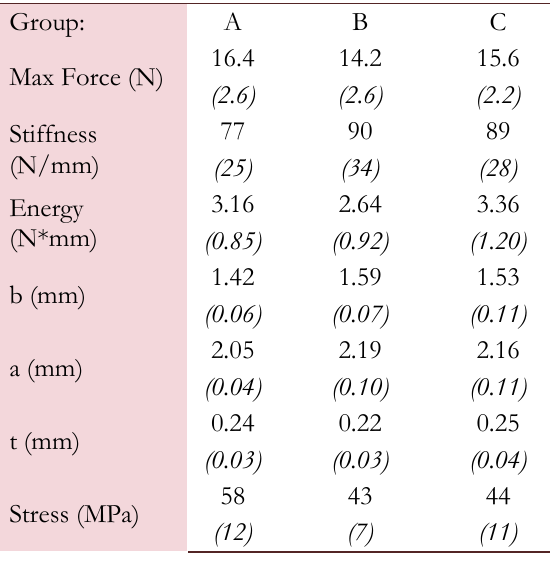
Table 1: The average values for the biomechanical parameters measured. The respective standard deviations are shown in brackets. One way ANOVA revealed statistically significant differences between the three groups in terms of minor axis length (b), major axis length (a) and thickness of the cross-section (t) and also in terms of ultimate stress (Fig. 4). No statistically significant difference was found in terms of force, stiffness or energy to failure.